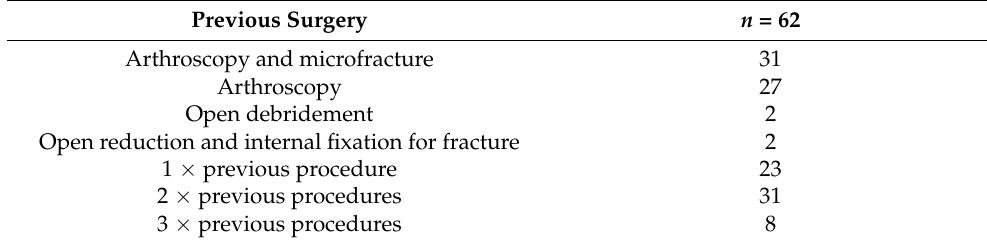
Table 2. Patients that had previously been operated on: details of first previous procedure and number of patients who had undergone 1, 2 and 3 previous procedures.